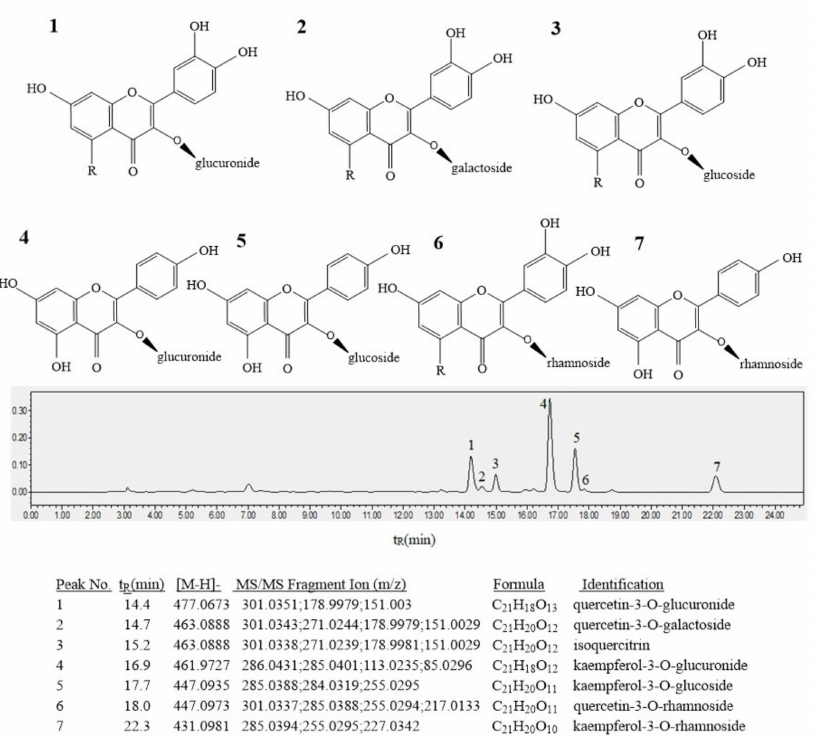
Figure 1. HPLC (High-performance liquid chromatography) chromatogram of treatment MFCB (co-inoculation with four strains) and the chemical structures of the seven flavonoids